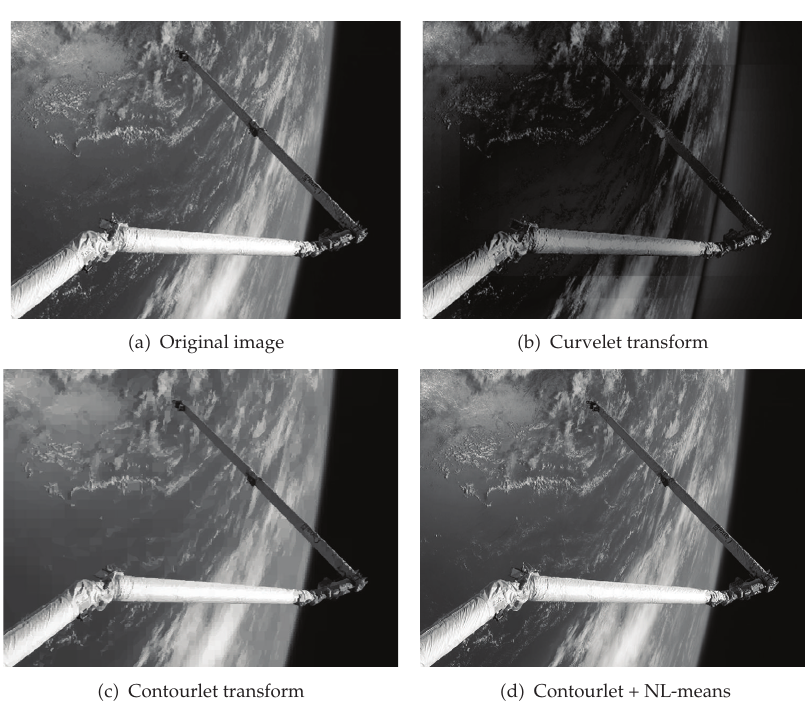
Figure 7: Process results for image